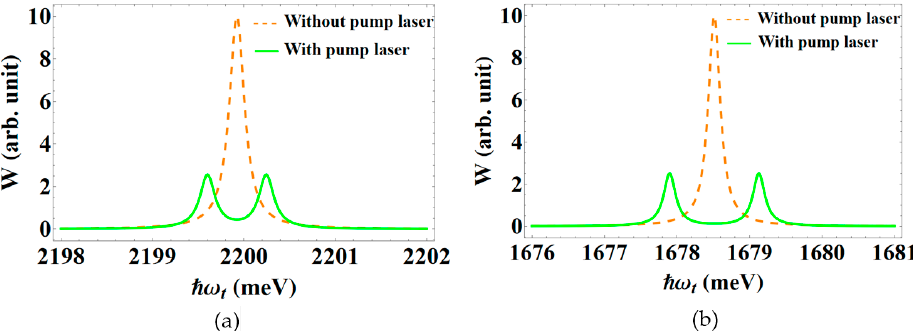
Figure 11. The interband absorption spectra in: ( a ) a conical QD with a spherical cap, with θ 0 = 60 ◦ ; and ( b ) a spherical QD [62], with the same radius R = 50 Å, and the pump laser’s detuning, (cid:125) ∆ ω = 0 meV.